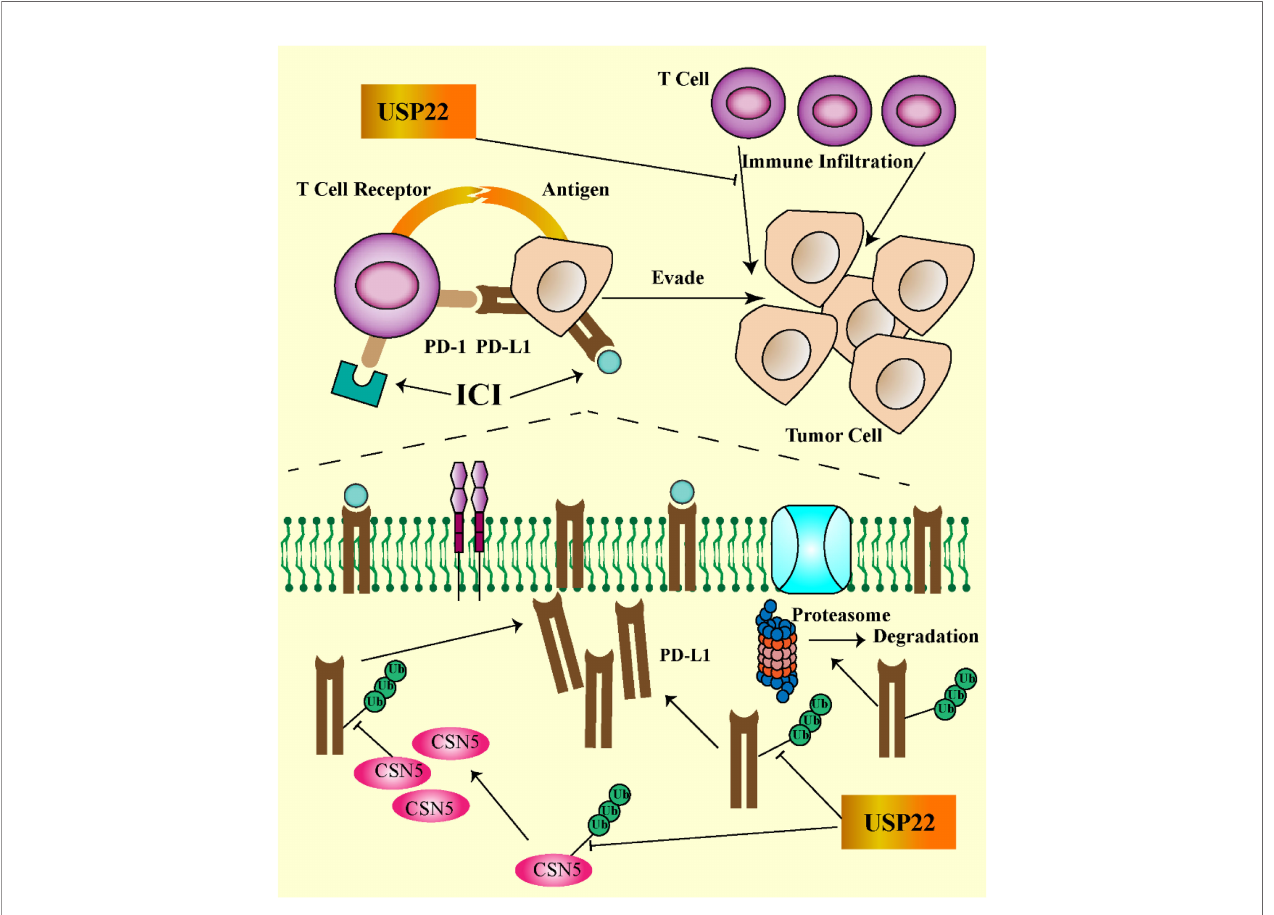
FIGURE 2 | USP22-mediated immune evasion (USP22 can directly regulate PD-L1 stability through deubiquitination; on the other hand, USP22 regulates PD-L1 protein levels through the USP22-CSN5-PD-L1 axis. USP22 expression inhibits T-cell in fi ltration into tumors. The PD-1/PD-L1 axis contributes to tumor cell escape by inhibiting T-cell